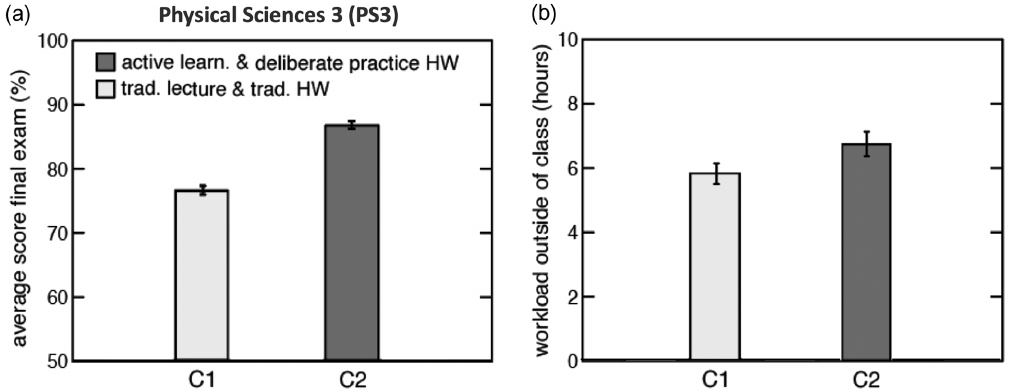
FIG. 3. (a) Measurement of the average percentage score for identical questions on the final examinations in PS3 for two cohorts of students over two consecutive years. The first cohort (C1) received a traditional treatment for the lecture and homework portions of the course. The second cohort (C2) experienced an entire course transformation, consisting of active learning in lecture and transformed homework (deliberate practice HW). (b) Student reported workload (outside of class, measured in hours). Error bars for both plots show 1